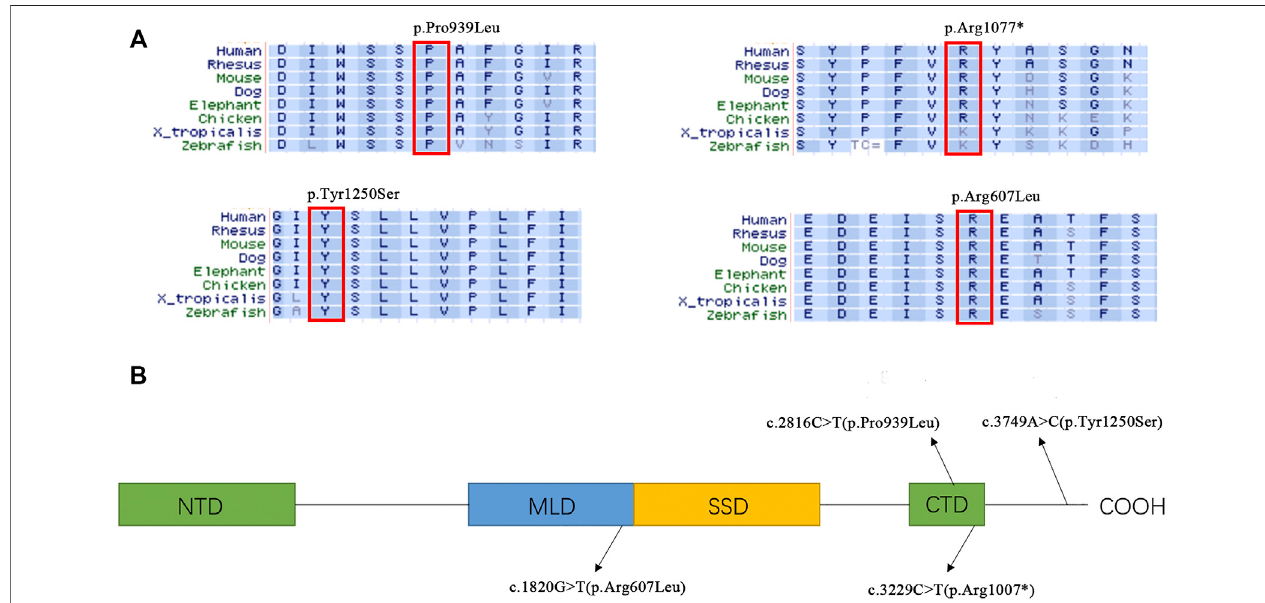
FIGURE2|(A) Alignmentofaminoacidsequencesindifferentorganism. (B) DistributionofthevariantsindifferentNPC1domainsNTD,N-terminaldomains.MLD, Middle Lumenal Domain; SSD, Sterol sensing domain; CTD, C-terminal